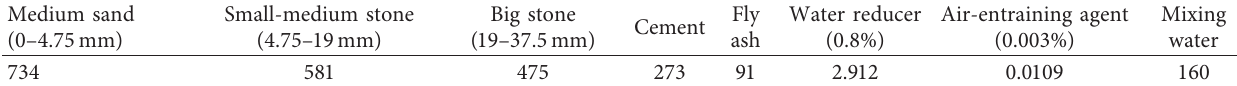
Table 1: Concrete mixture ratio (kg/m 3